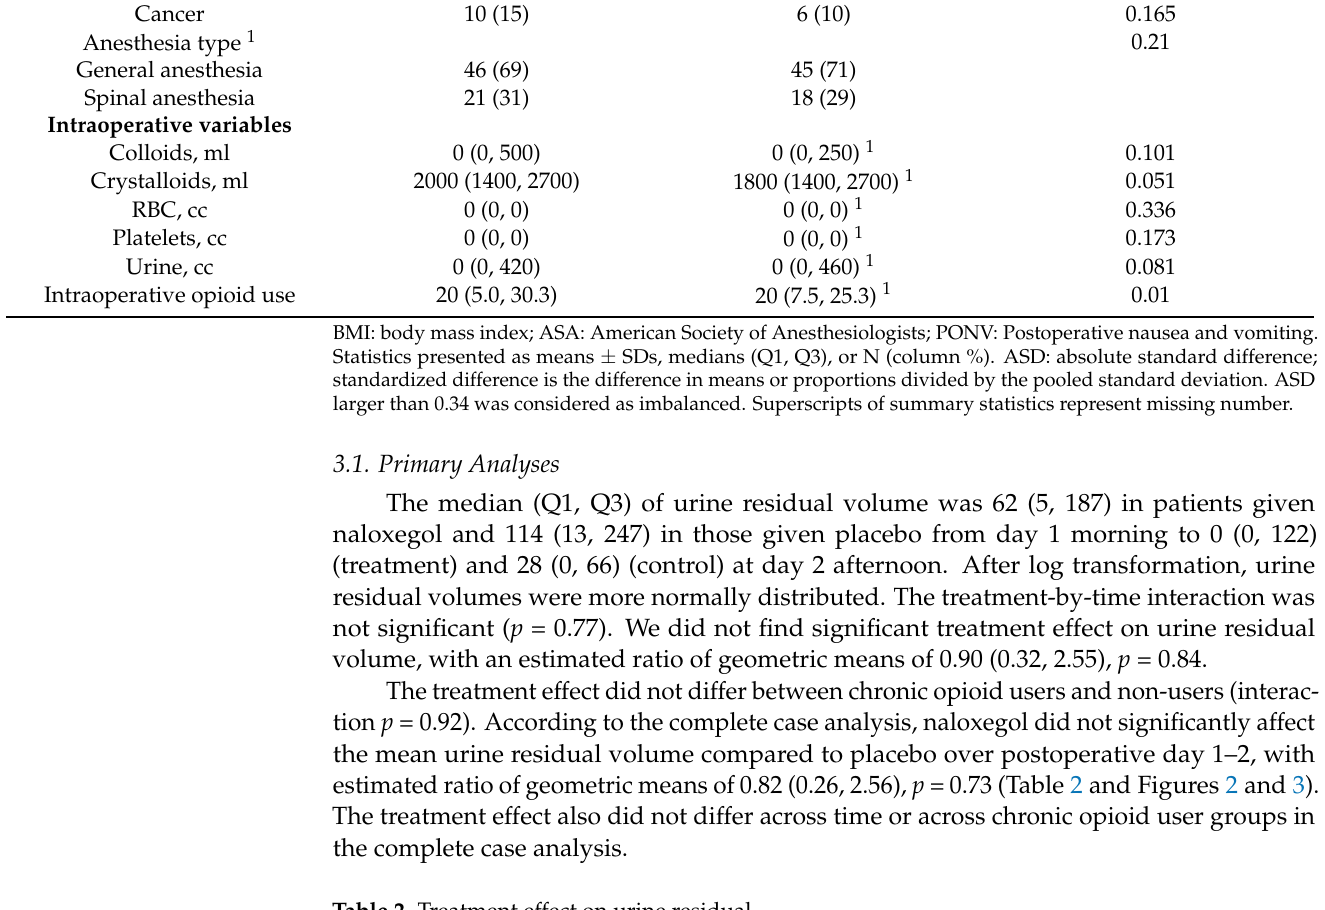
Table 2. Treatment effect on urine